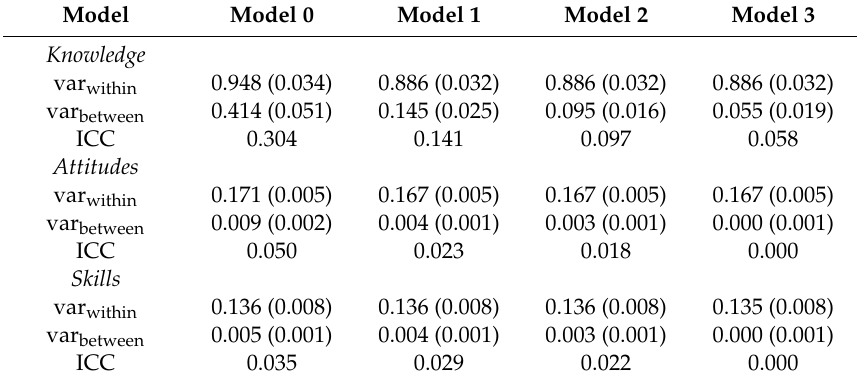
Table A4. Variance and intraclass correlations of citizenship